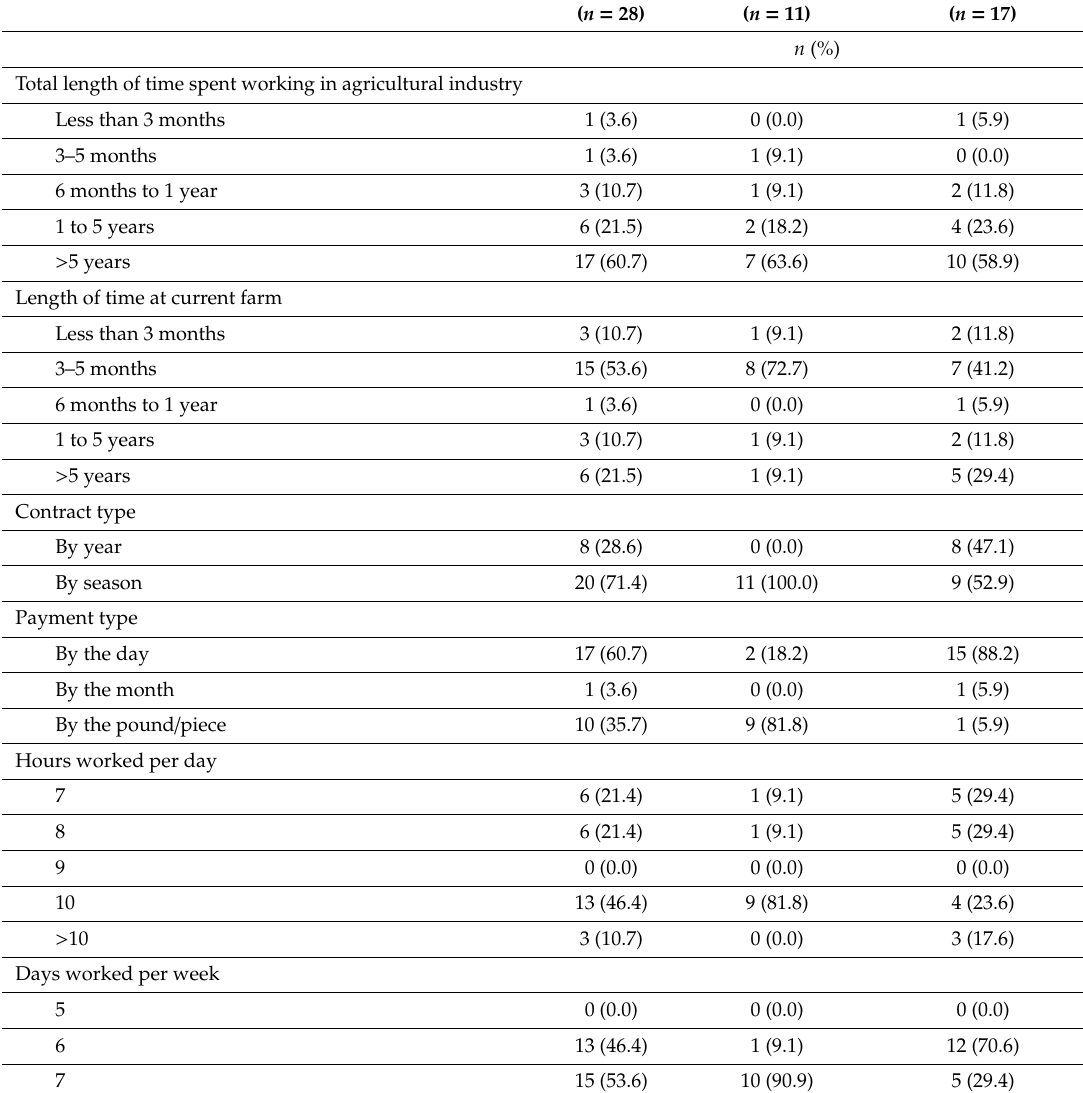
Table 2. Participant self-reported work details by